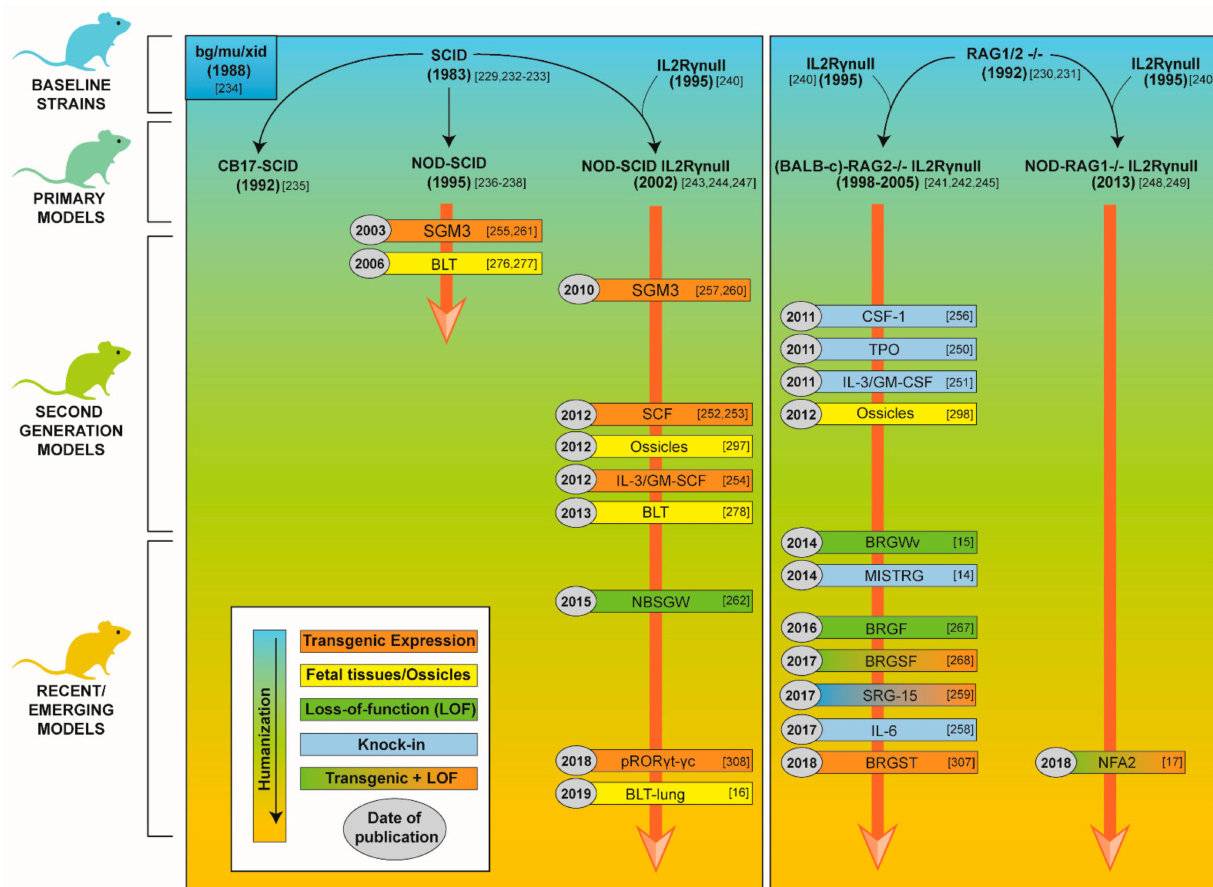
Figure 1. Development of human immune system mice. Schematic illustration displaying the di ff erent human immune system mice (HIS mice) developed since